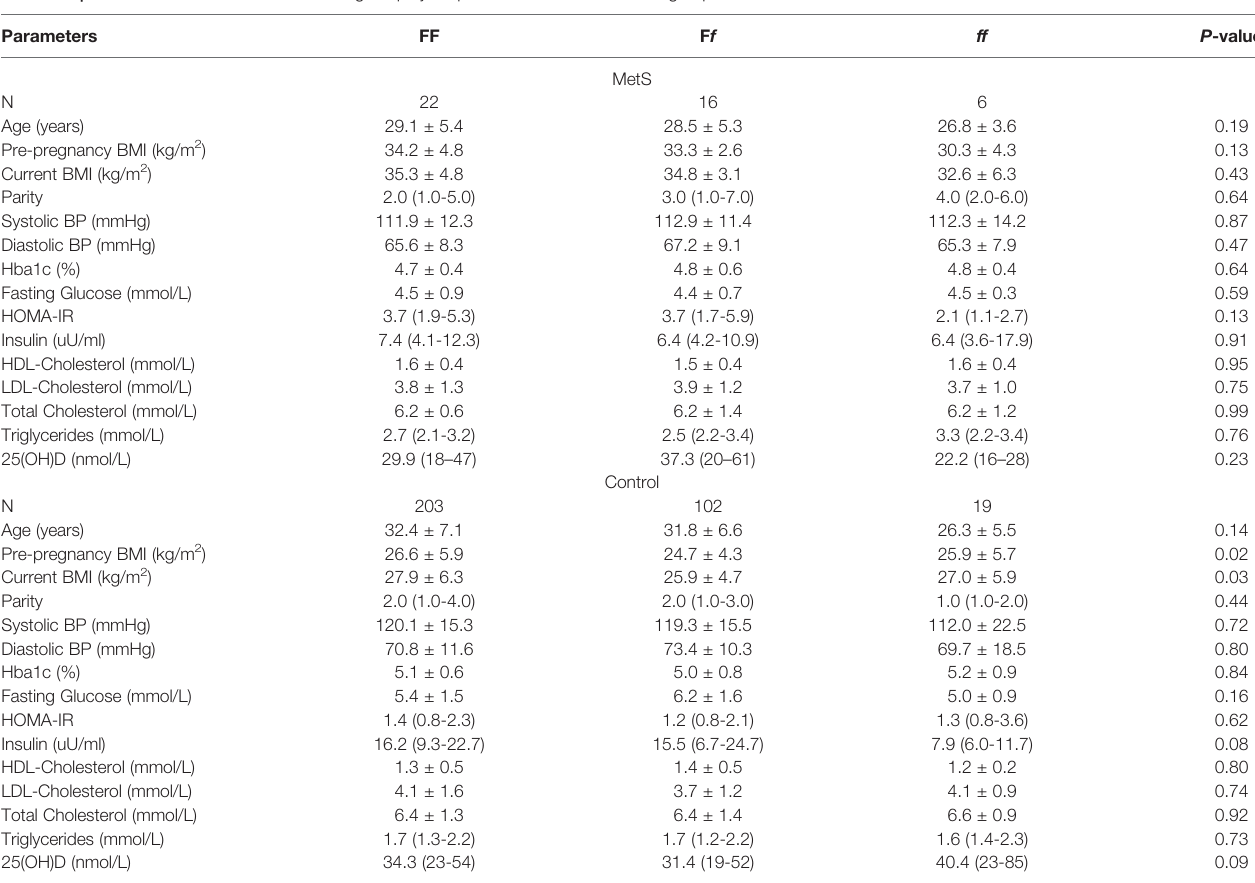
FFdenotesnormalhomozygous,Ffdenotesheterozygousandffdenoteshomozygousgenotypes.Datarepresentmean±SDandmedian(25 th and75 th )percentileforGaussianandnon- Gaussian variables. P-value signi fi cance at 0.05.